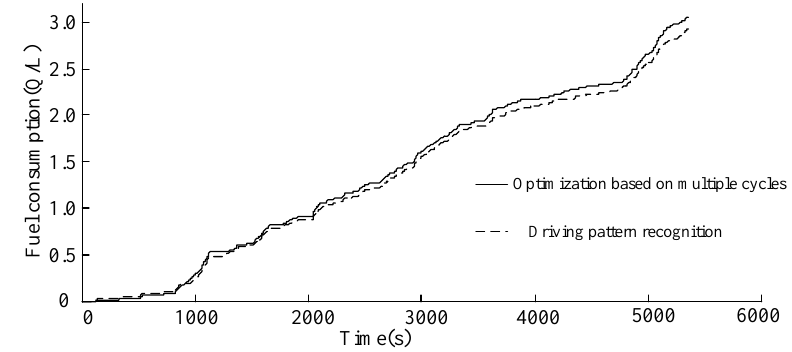
Figure 17. Fuel consumption under comprehensive driving cycle conditions.